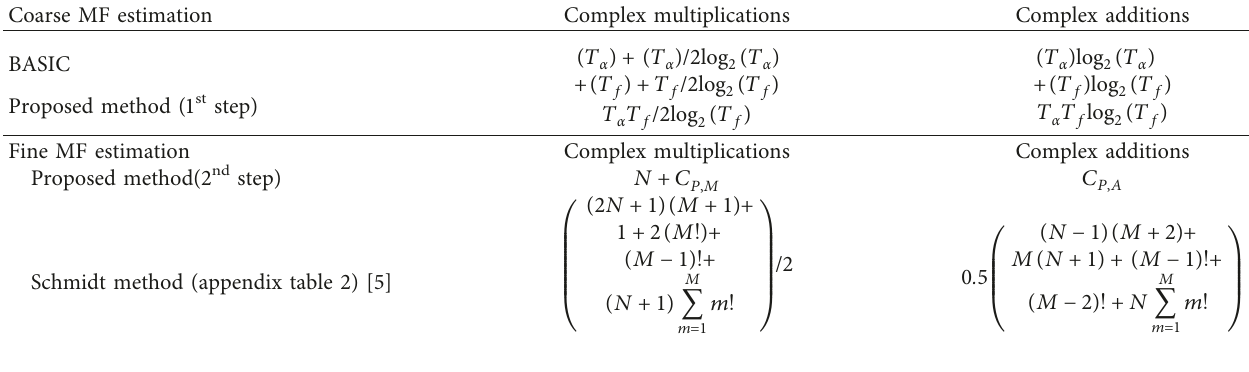
Table 1: Computational burdens comparison.